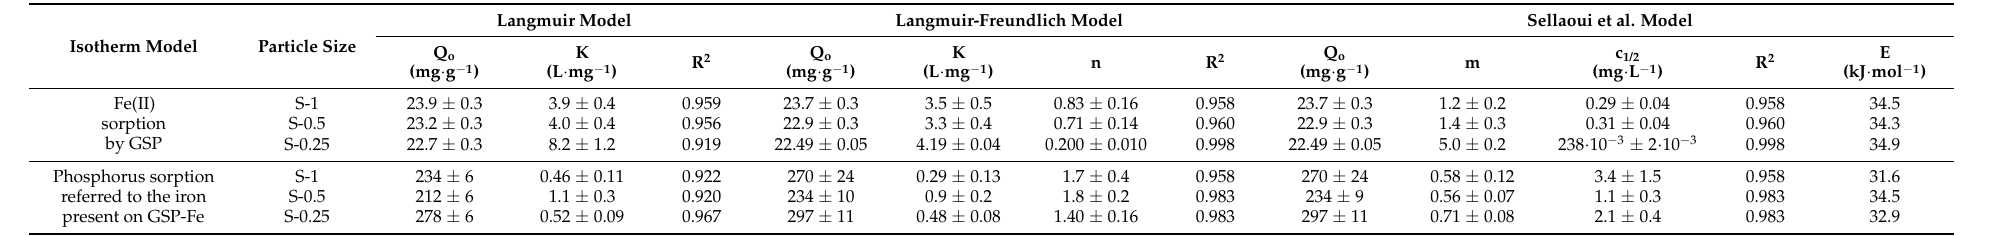
Table 3. Sorption parameters obtained from the isotherm models for iron adsorption on GSP and phosphorus adsorption on GSP-Fe at room temperature (20 ◦